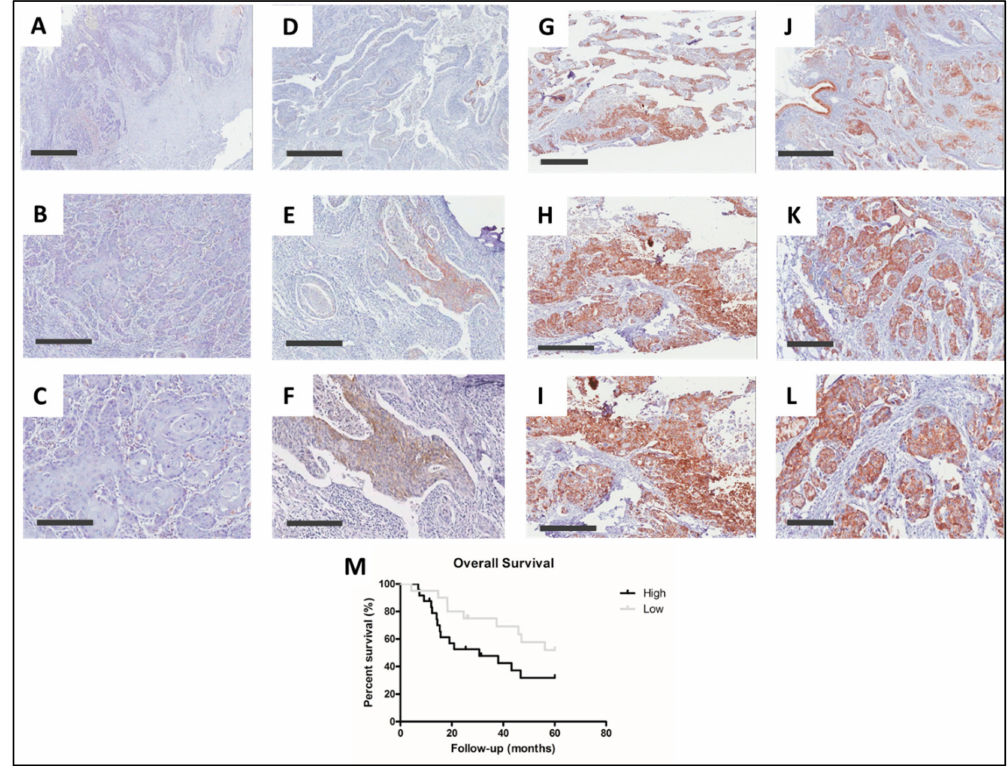
Figure 3. ALCAM protein levels in LSCC and its association to prognosis. Representative micrographs of ALCAM protein expression analysis by immunohistochemistry performed in 44 LSCC. In this analysis, 27.3% of LSCC showed no ALCAM expression ( A – C ). Among ALCAM positive tumors, 25% of samples showed expression in less than 20% of cells being categorized as low ALCAM expression ( D – F ). LSCC samples with more than 20% of positive cells were categorized as high ALCAM expression ( G – L ). ( G – I ) Representative LSCC with ALCAM staining in 70% of cells. ( J – L ) Representative LSCC with ALCAM staining in 80% of cells. ( M ) LSCC presenting ALCAM protein low levels have a better prognosis than LSCC overexpressing ALCAM protein ( p = 0.04, HR = 2.31, 95% CI 1.03 – 5.28). ( A , D , G , J ) grey bar represents scale 1 mm. ( B , E , H , K ) grey bar represents scale 400 µ m, ( C , F , I , L ) grey bar represents 200 µ m. Black line, ALCAM high levels; grey line, ALCAM low levels. Groups were made according to ALCAM median value of positive